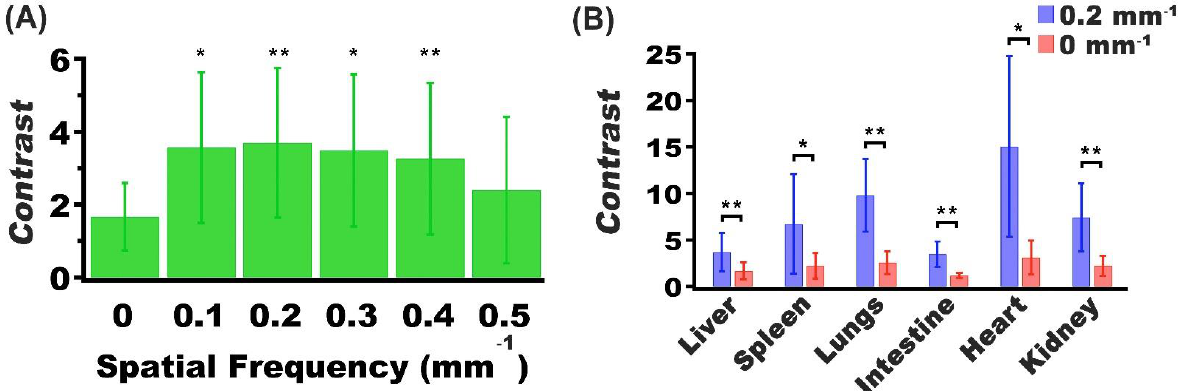
Figure 7. Mean and SD values of the contrast between ( A ) tumor and liver for spatial frequencies in the range of 0–0.5 mm −1 , and ( B ) tumor and various organs for spatial frequencies of 0 and 0.2 mm −1 . In both panels, n = 5 for each organ and tumor. In panel ( A ), asterisks indicate that the mean contrast value at those spatial frequency values ( f x = 0.1, 0.2, 0.3. and 0.4 mm −1 ) were signficantly different from the mean contast at DC imaging ( f x = 0.0). In panel ( B ), asterisks indicate statistically significant differences in mean contrast between imaging at f x = 0.2, mm −1 and DC imaging for the indicated organs. In both panels, * and ** indicate p < 0.05, and p < 0.01, respectively.